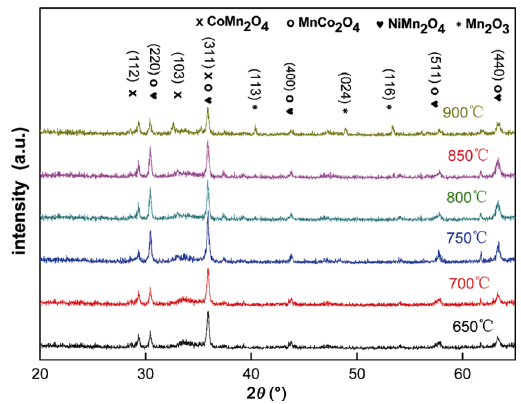
Fig. 2 XRD patterns of MCNO thin films at different annealing